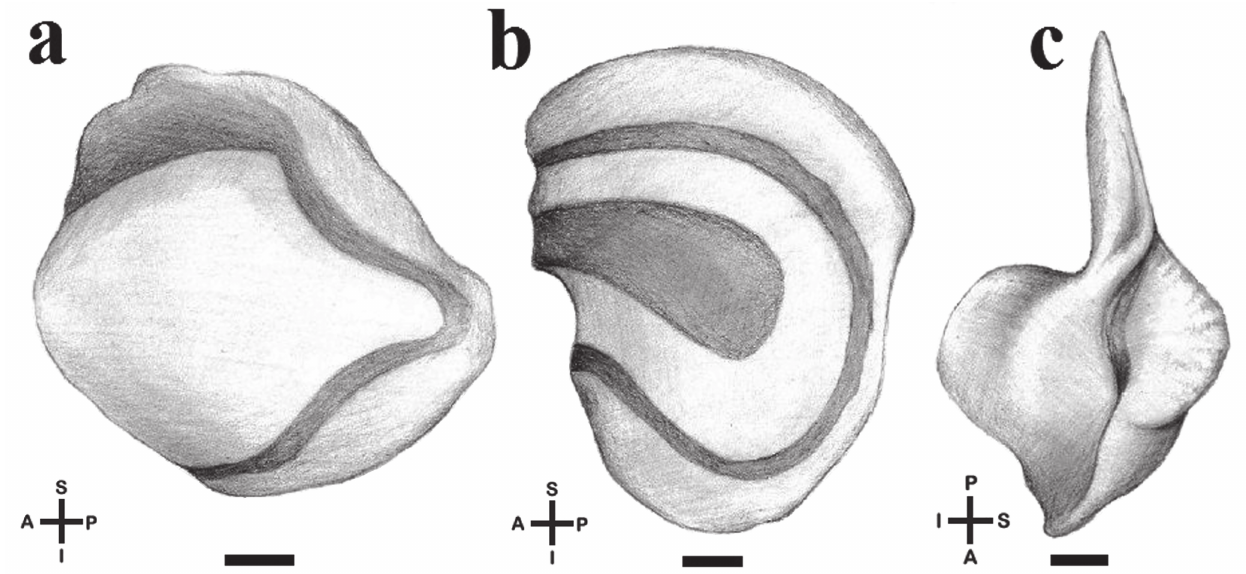
Fig. 12. Right serie of otoliths of Ancistrus cirrhosus (a) Lapillus, Scale bar = 100 µm; (b) Asteriscus, Scale bar = 100 µm; (c) Sagitta, Scale bar = 100